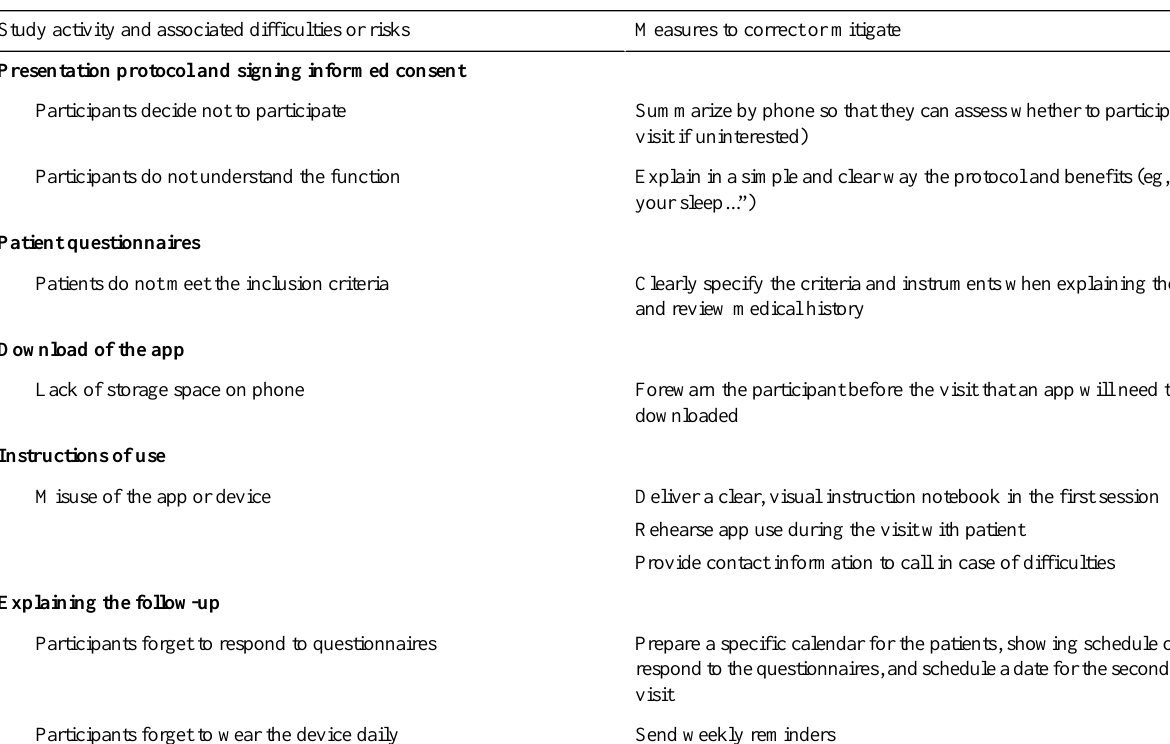
Table 3. Difficulties associated with activities of the in-person visit and their correction